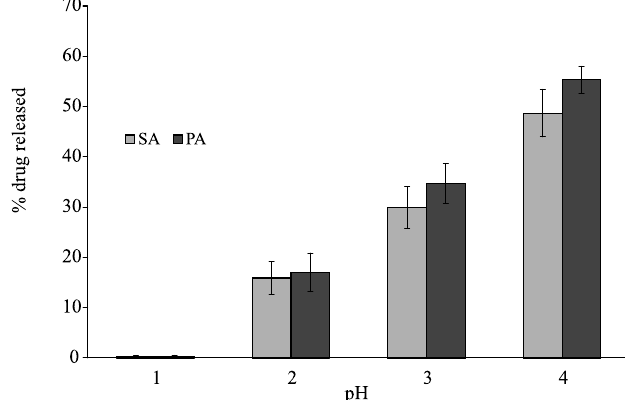
FIGURE 7 - Disintegration pH of 5 %w/w enteric coated pellets as determined by drug release (mean ± SD, n = 3).